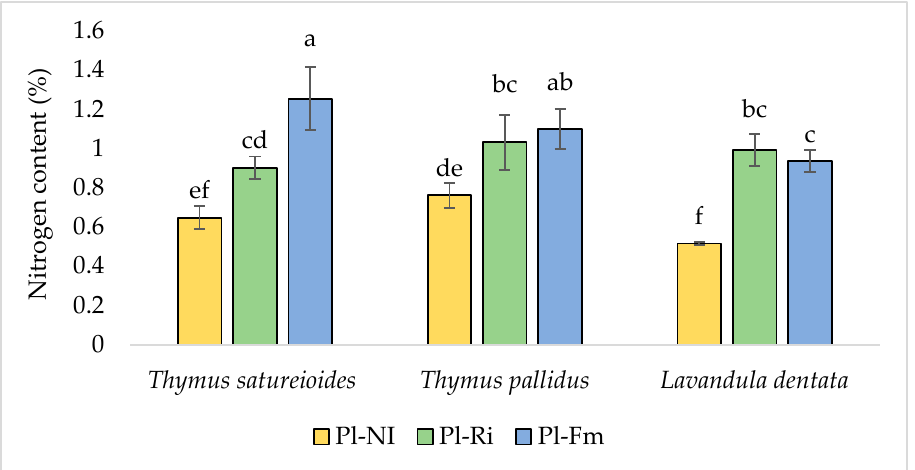
Figure 6. Nitrogen content (%) in Thymus satureioides (Ts), Thymus pallidus (Tp), and Lavandula dentata (Ld), non-inoculated (NI) or inoculated with Rhizophagus irregularis (Ri) or Funneliformis mosseae (Fm) after 4 months of culture under greenhouse conditions. Bars followed by the same letter are not significantly different according to Tukey’s HSD test ( p < 0.05).